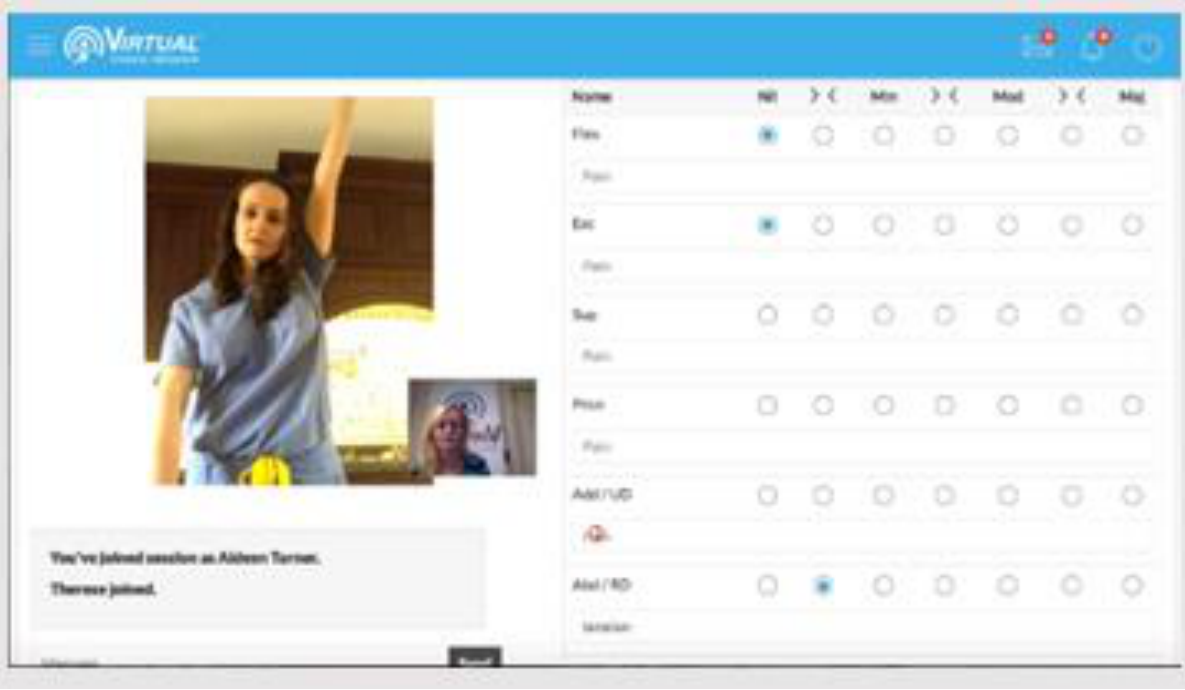
Figure 2. Clinician’s view: The clinician utilizes a computer with left side video and right digital